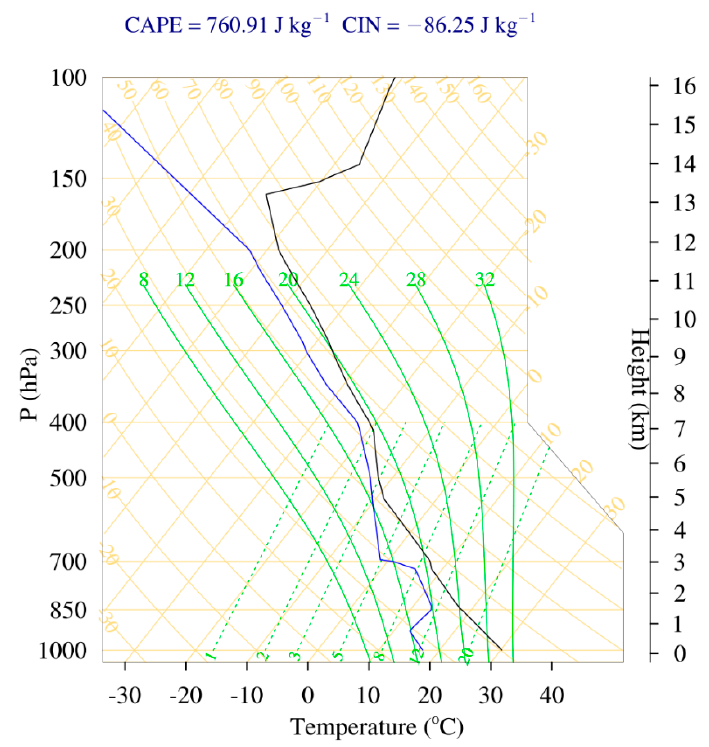
Figure 1. The skew − T diagram of the initial profiles of temperature (black line) and dew point temperature (blue line) used in this study.